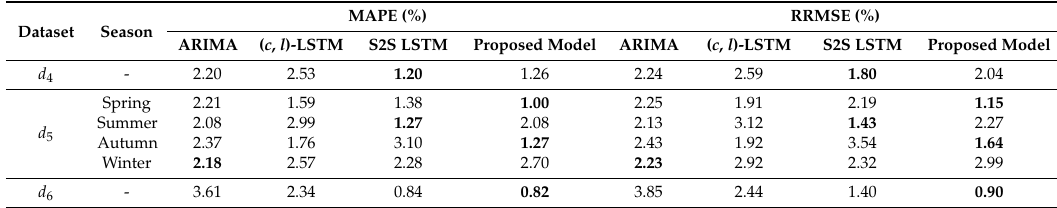
Table 6. Errors for d 4, d 5 and d 6 .